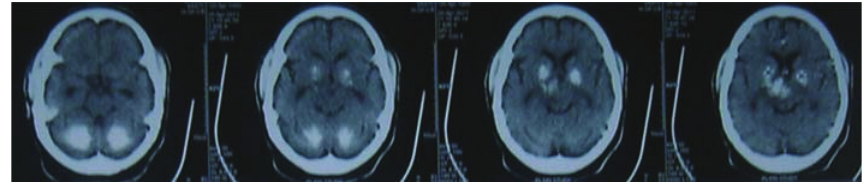
Figure 2: Plain CT scan of head showed bilateral basal ganglia and cerebellar calcification with right thalamic and midbrain hemorrhage without any midline shift.